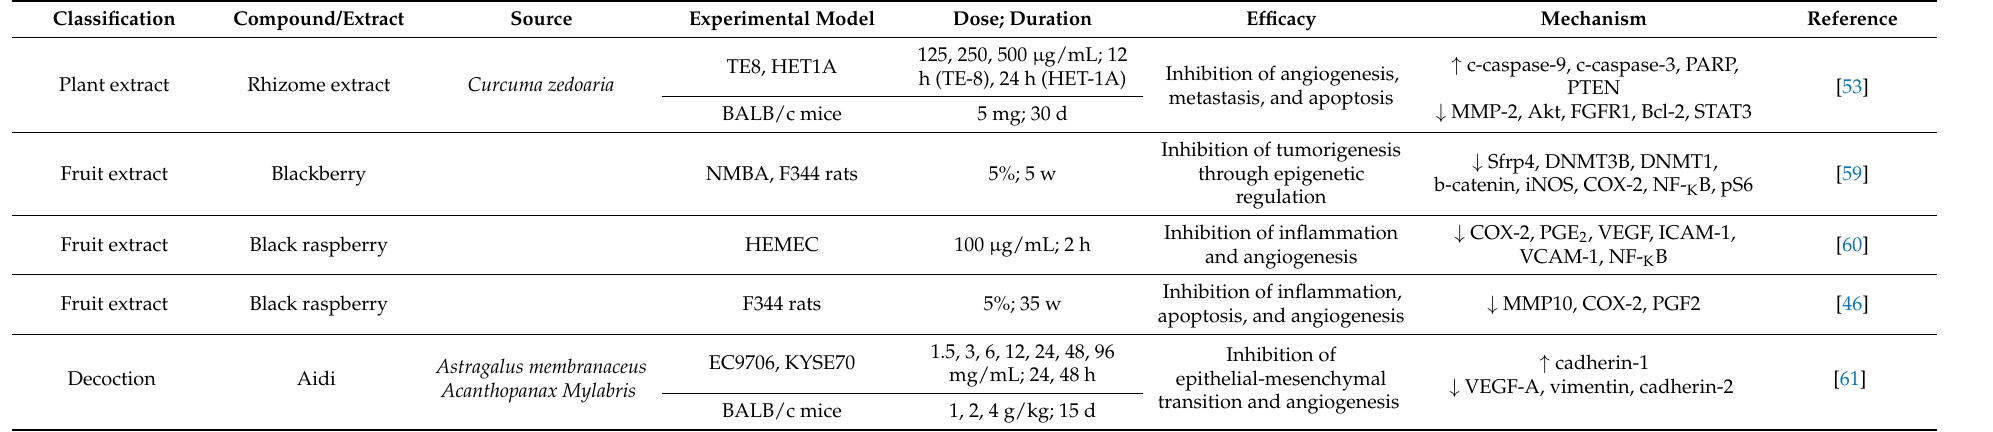
Table 2. Anti-angiogenesis-related natural